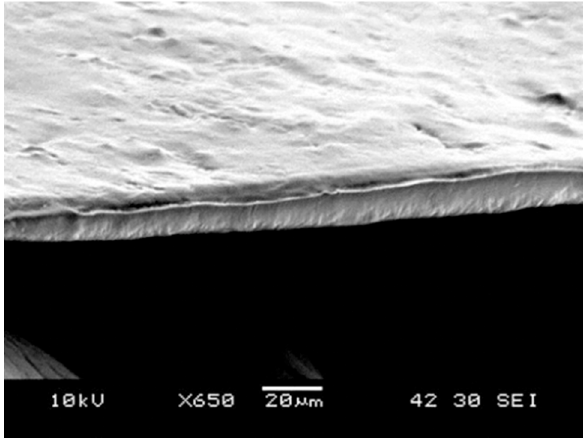
Figure 3. The cross-section of a PCL membrane made from 100 µm powder.